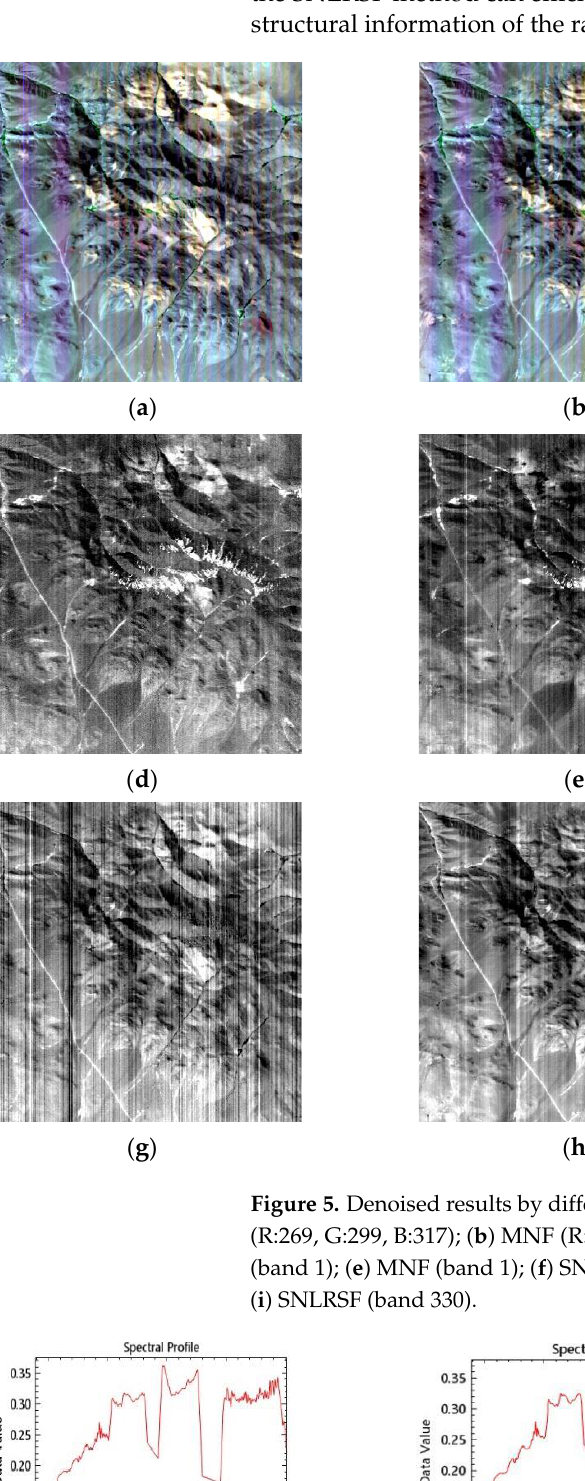
( c ) Figure 6. The spectral curve of a point (lat: 32.8°, lon: 37.6°): ( a ) Original; ( b ) MNF; and ( c ) SNLRSF.